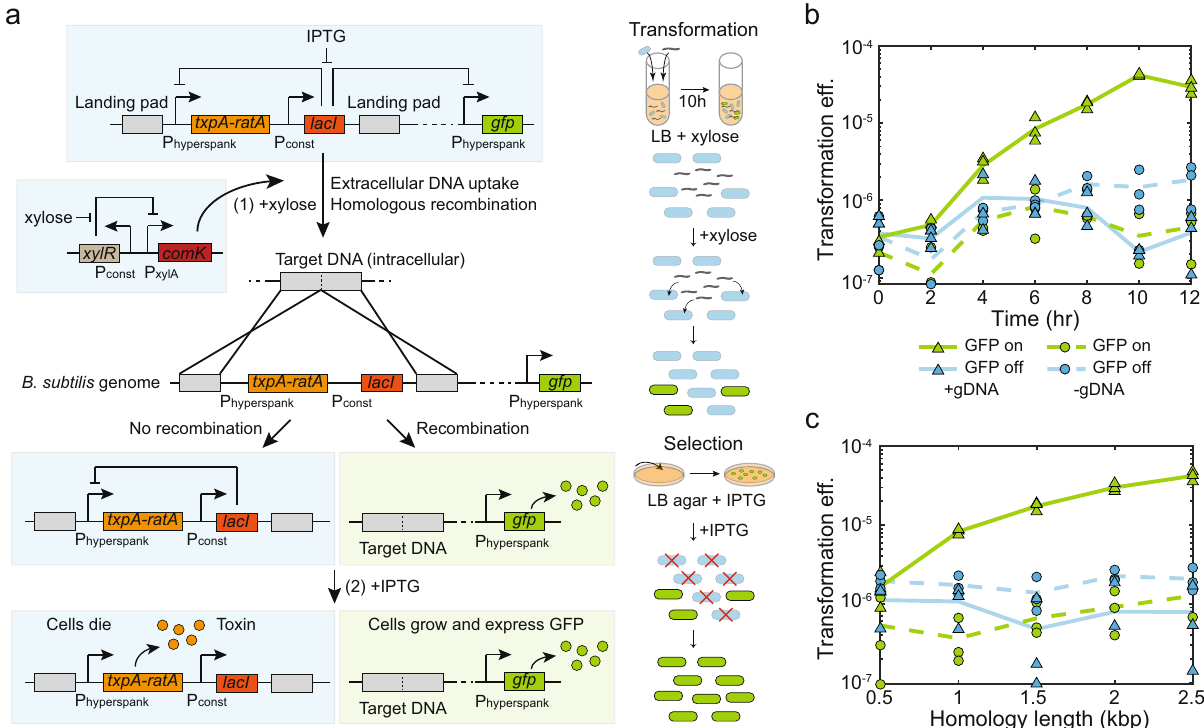
Fig.1|Constructionofalivingcell-basedDNAsensor.a Schematicofasynthetic genetic circuit constructed in B. subtilis that allows the recognition of speci fi c extracellularDNAsequences.Thexylose-induciblemasterregulatorofcompetence comK induces B. subtilis natural competence. The repressor LacI regulates the expression of the toxin-antitoxin system txpA - ratA and fl uorescent protein sequences. Inthepresenceof targetDNA,homologousrecombinationwillremove the toxin and the repressor, allowing a sub-population of transformed cells to